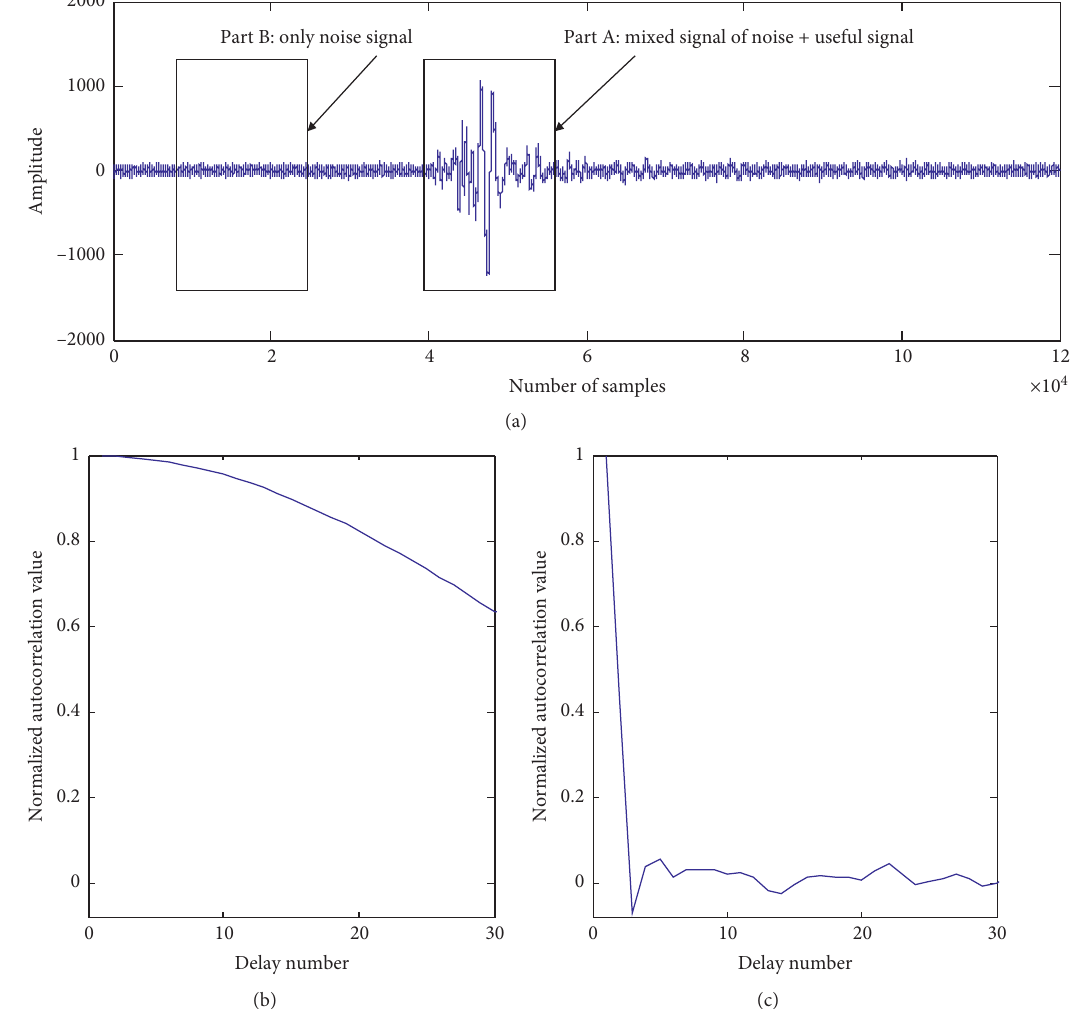
Figure 2: Autocorrelation results of signal and noise, respectively. (a) Underground explosion vibration signal. (b) Autocorrelation characteristic curve of Part A. (c) Autocorrelation characteristic curve of Part B.